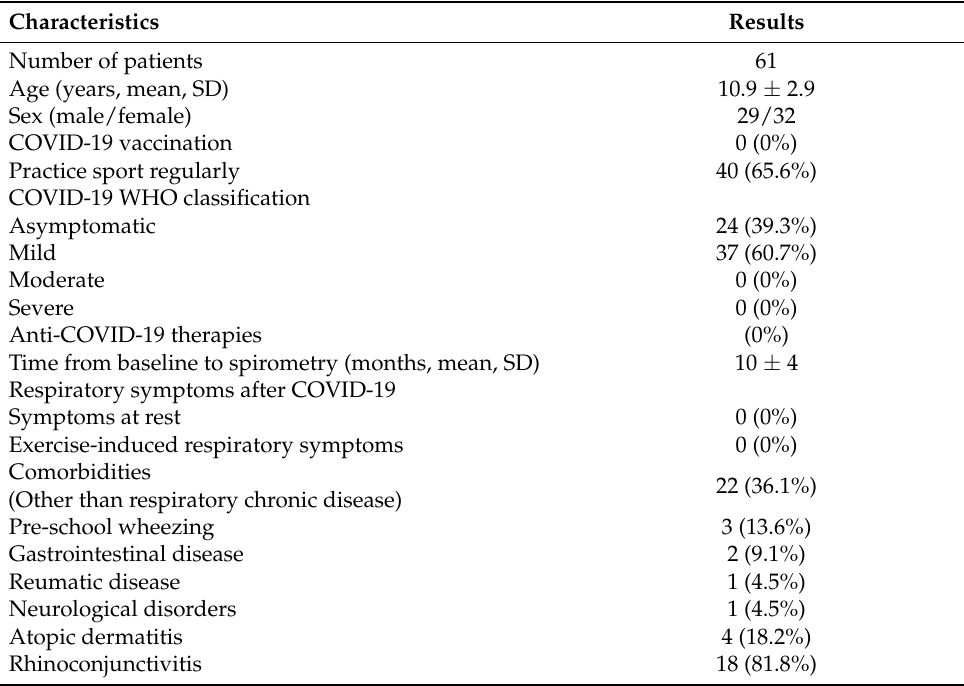
Table 1. Demographic and clinical features of the 61 enrolled subjects.